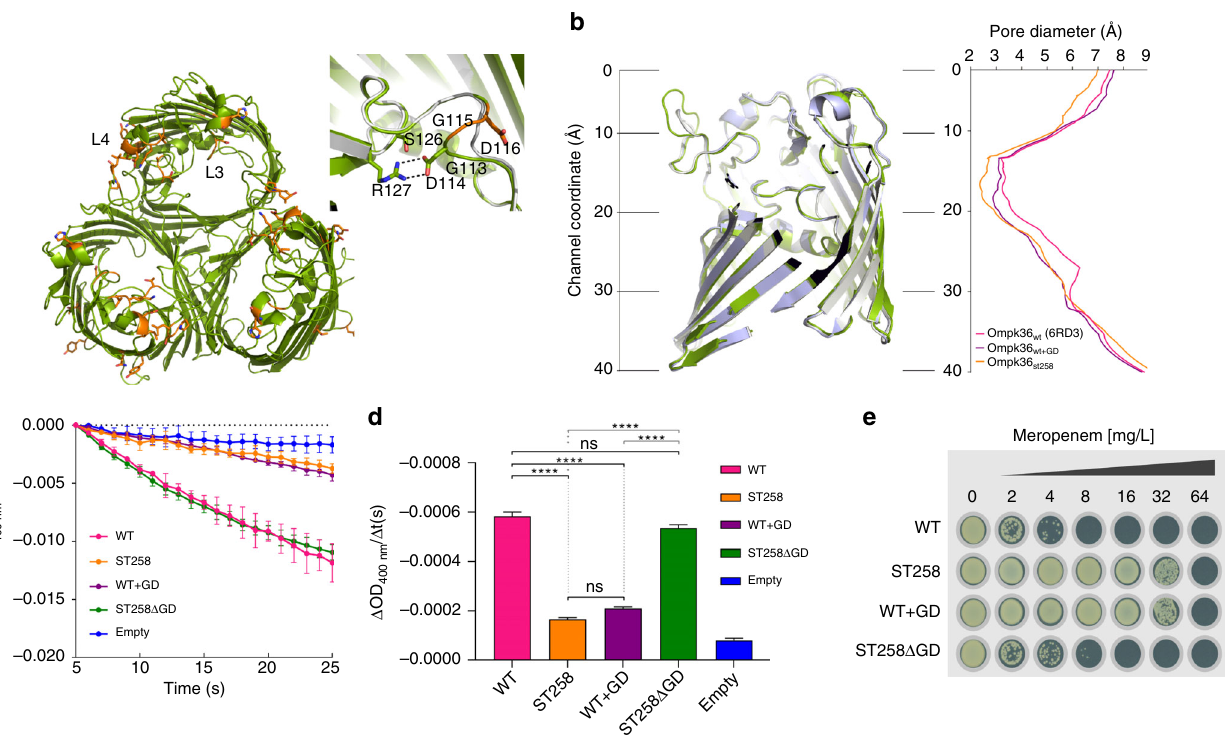
Fig. 3 Gly-Asp insertion in L3 of OmpK36 reduces pore diameter, restricts Meropenem diffusion and mediates Meropenem resistance. a Cartoon representation of the OmpK36 ST258 trimer. The OmpK36 ST258 mutations have been mapped onto the structure. All mutations are shown as orange sticks. The majority of the mutations are found in L3/4. Inset: close-up view of the pore constriction zone. In order to accommodate the GD insertion, L3 has undergone a conformational change, stabilised by a salt-bridge, with subsequent constriction of the pore relative to the OmpK36 WT (shown in grey cartoon). b Lateral view of OmpK36 monomer aligned to minimal pore diameter graph, calculated using the HOLE algorithm, demonstrating a reduction in minimal pore diameter in both OmpK36 ST258 and OmpK36 WT + GD compared with OmpK36 WT . c OmpK36 isoforms were reconstituted into proteoliposomes and Meropenem diffusion was assessed by liposomal swelling assay. Meropenem in fl ux is reduced in OmpK36 ST258 compared with OmpK36 WT. This effect is abolished by GD deletion (OmpK36 ST258 Δ GD ) and reproduced by GD insertion (OmpK36 WT + GD ) ( n = 3 repeats, error bars = ± s.d). d Calculated Meropenem uptake rate over 20 seconds ( Δ OD 400nm / Δ t(s)) from ( c ). **** p < 0.0001, error bars ± s.e.m. e GD insertion in OmpK36 isoforms mediates Meropenem resistance assayed by agar dilution in KP (OmpK35 ST258 background with KPC-2). Substitution of OmpK36 WT with OmpK36 WT + GD increases the MIC to that of OmpK36 ST258 , a phenotypic pattern reversed by GD deletion in the OmpK36 ST258 Δ GD